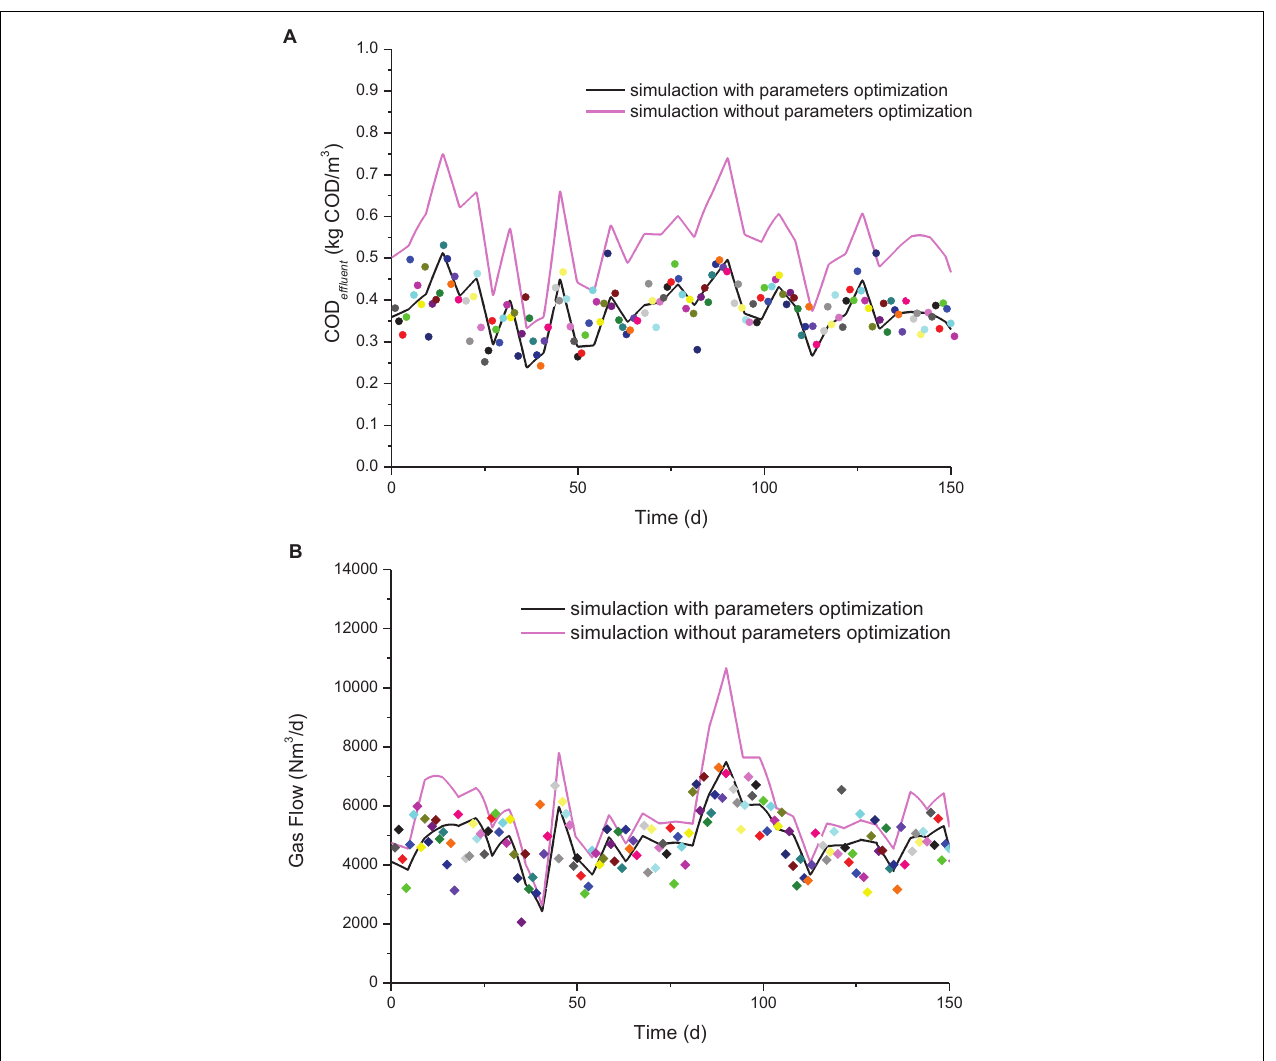
FIGURE 3 | Schematic of comparing simulation result with measured values (color oblique square dot) for IC reactors using 150 days estimation period. (A) Simulation comparison of COD eff . (B) Simulation comparison of biogas production